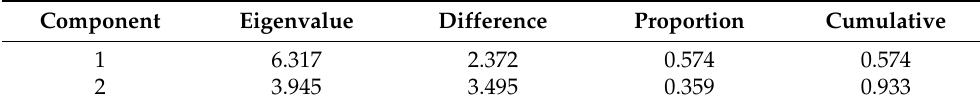
Table 8. Eigenvalues and variance explained by the first two principal components for the fatty acids of EVOOs.